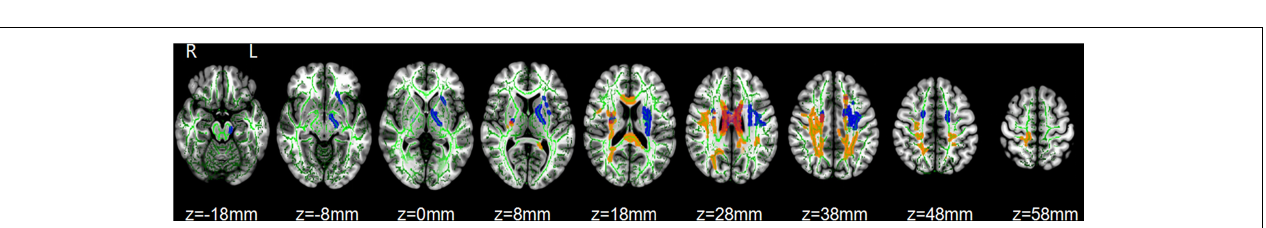
FIGURE 2 | TBSS analysis of symptomatic patients with Creutzfeldt–Jacob disease (CJD) compared with healthy controls. Increased MD was detected in patients with CJD compared with healthy controls (FWE correction, P < 0.05). Significant areas of increased MD (red code) in patients with CJD versus healthy controls are shown with the skeleton (green).